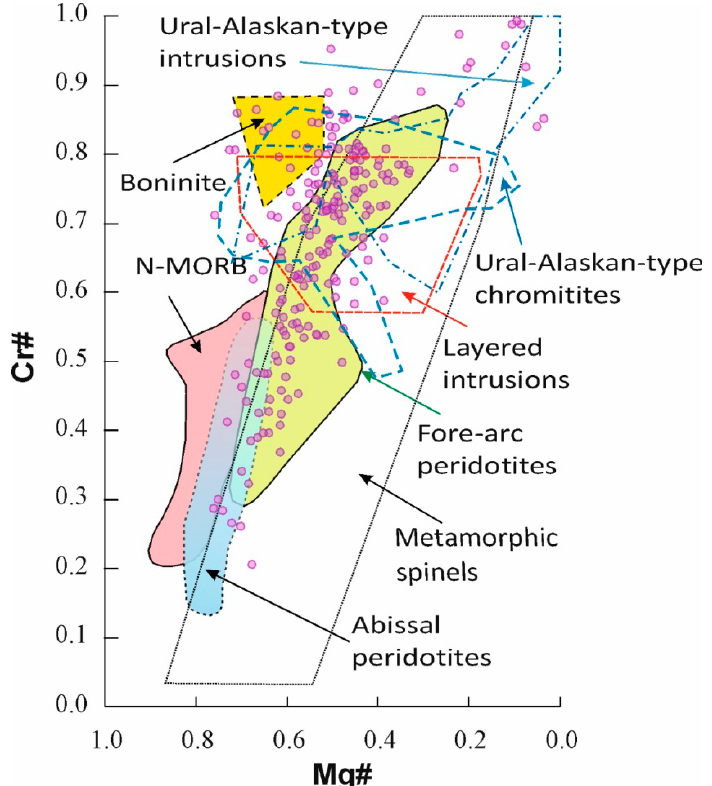
Figure 10. Diagram Mg#–Cr# for chromspinel from Sabantuy paleoplacer. Fields for chromspinel in abyssal peridotites, boninite, N-MORB and layered intrusions were taken from [3]; fields for Alaskan-type intrusions were taken from [42]; fields for Ural-Alaskan-type chromitites were taken from [34]; fields for fore-arc peridotites were taken from [43]; the field for metamorphic spinel was taken from [44].